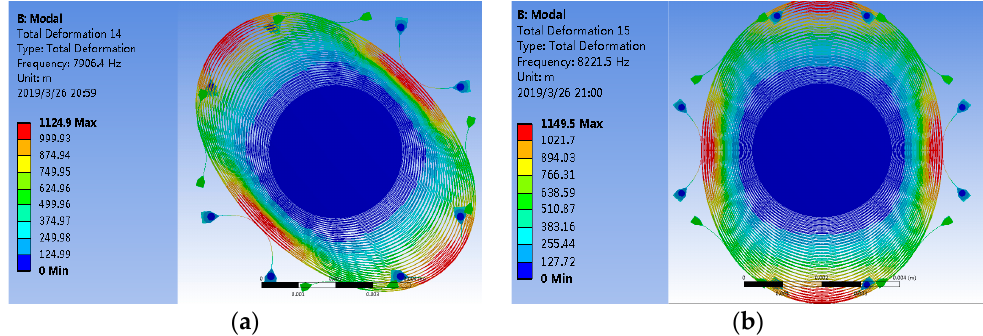
Figure 2. Diagram of the micro-electro-mechanical (MEMS) disk resonator modes: ( a ) Drive mode; ( b ) Sense mode.